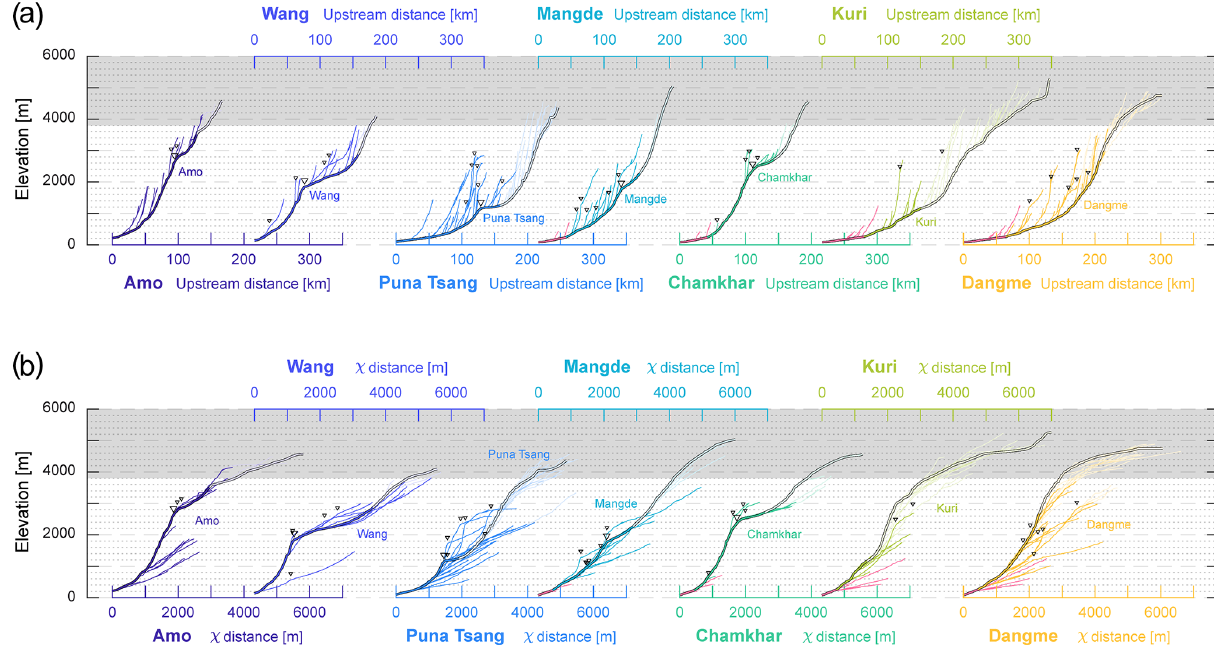
Figure 6. Longitudinal ( a – top) and transformed χ ( b – bottom) profiles of major rivers of Bhutan and of their tributaries (with drainage area > 50km 2 ) (location in Fig. 1). Major drainage basins (and the corresponding horizontal axes of their profiles) are color-coded as in Fig. 1. Trunk streams are reported in bold lines and tributaries in thinner lines. Lighter transparent colors are used for the river portions north of physiographic transition T3. Major knickpoints are pointed out by triangles. Altitudes above 3800m are considered aside (grey band) as rivers may preserve a glacial imprint in these regions. χ -transformed profiles are established with a concavity of 0.5. Other concavities have been tested and are illustrated in Fig. S2 in the Supplement. For an easier reading of the figure, horizontal axes (distance or χ ) are alternatively reported below or above the graphs and follow the same color code as that of the rivers they are associated